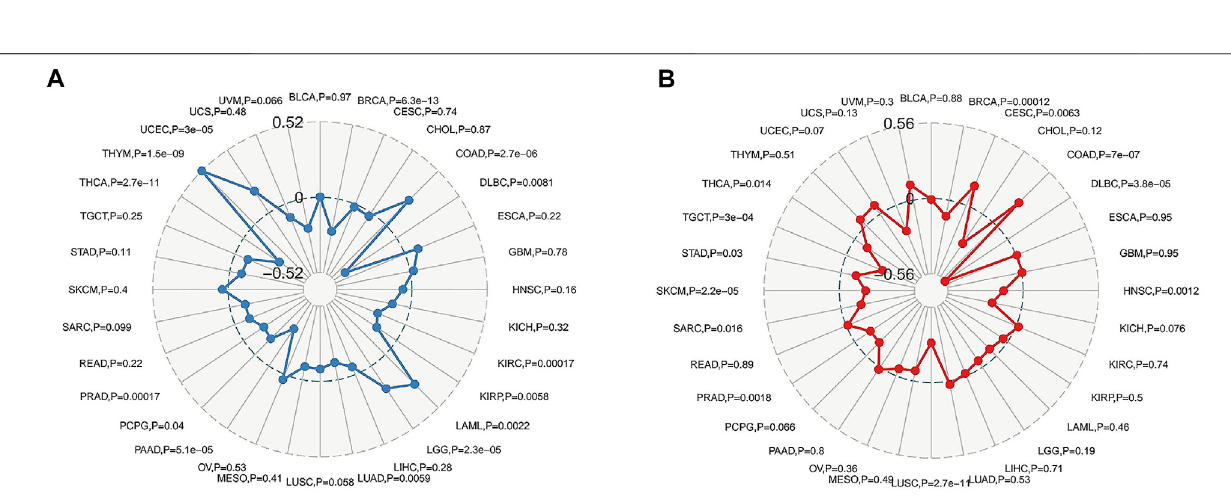
Frontiers in Genetics |